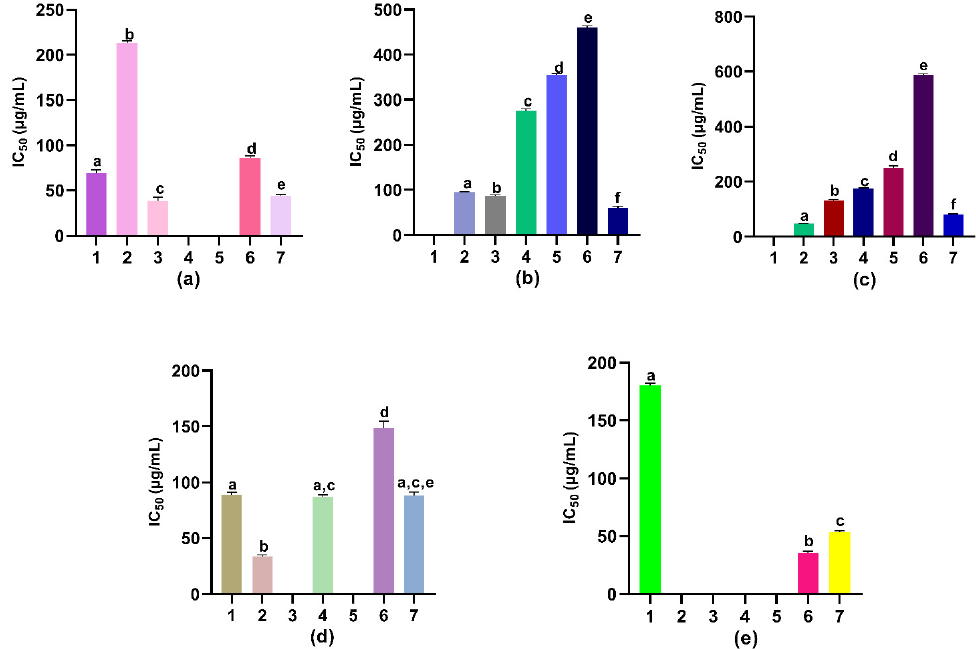
Figure 8. Inhibitory activity of hydroalcoholic extracts from edible plant organs from Solanum nigrescens ( 1 ), Sechium edule ( 2 ), Rumex obtusifolius ( 3 ), Amaranthus hybridus ( 4 ), Piper auritum ( 5 ), Rhamnus pompana ( 6 ), and Yucca aloifolia ( 7 ) on pancreatic lipase ( a ), α -glucosidase ( b ); α -amylase ( c ), HMG-CoA reductase ( d ), and ornithine decarboxylase ( e ). Different letters indicate means ( n = 25) with statistically significant differences by ANOVA–Tukey’s test at p < 0.05. Detailed information can be found in Table S7. The extracts of Y. aloifolia caused an evident inhibition of both AG (IC 50 , 60.04 µg mL − 1 ) and AA (IC 50 , 79.62 µg mL − 1 ), but the most effective extract on AA was that of S. edule (IC 50 , 47.4 µg mL − 1 ) (Figures 8b,c). The same extract and that of R. obtusifolius had accepta- ble inhibitory activity on AG, whereas the extracts of R. obtusifolius , A. hybridus and P. auritum were effective against AA (Figures 8b,c). The ethanolic extract from the berries of S. nigrescens has no effect on both enzymes. The IC 50 of these extracts was comparable to that reported for the essential oil from D. foliolosa on AG and AA [17]. The function of AG